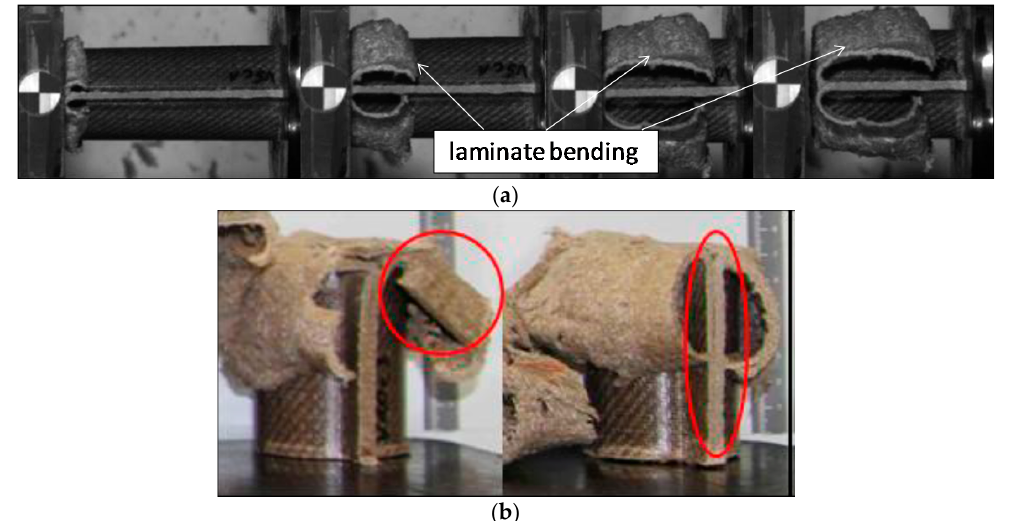
Figure 13. Results of failure mechanisms for V5 and V10 materials. ( a ) Laminate bending mechanism for V5_c during a crash test. ( b ) Rear and front part of V10_c specimen crashed.